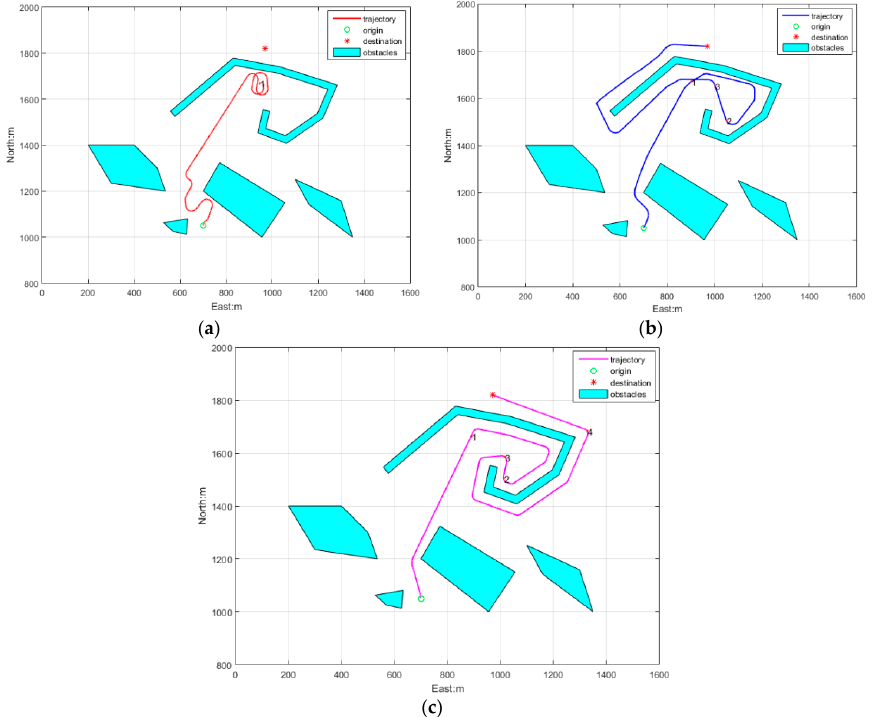
Figure 14. Trap obstacles environment obstacle avoidance algorithms : ( a ) APF; ( b ) PSO; ( c ) RRA .